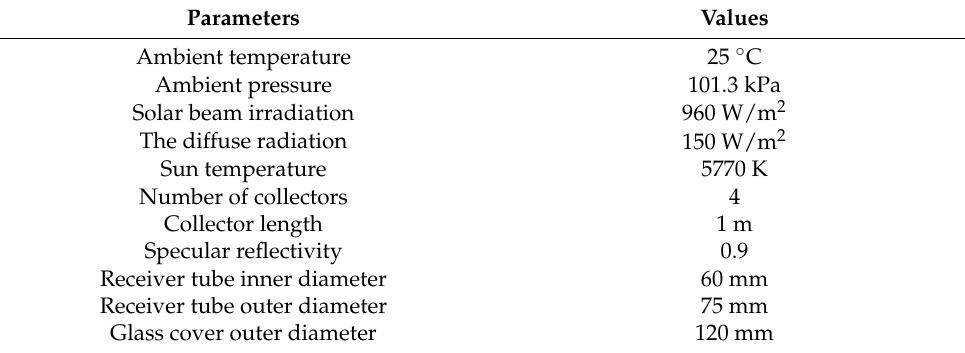
Table 1. Input data used in the system